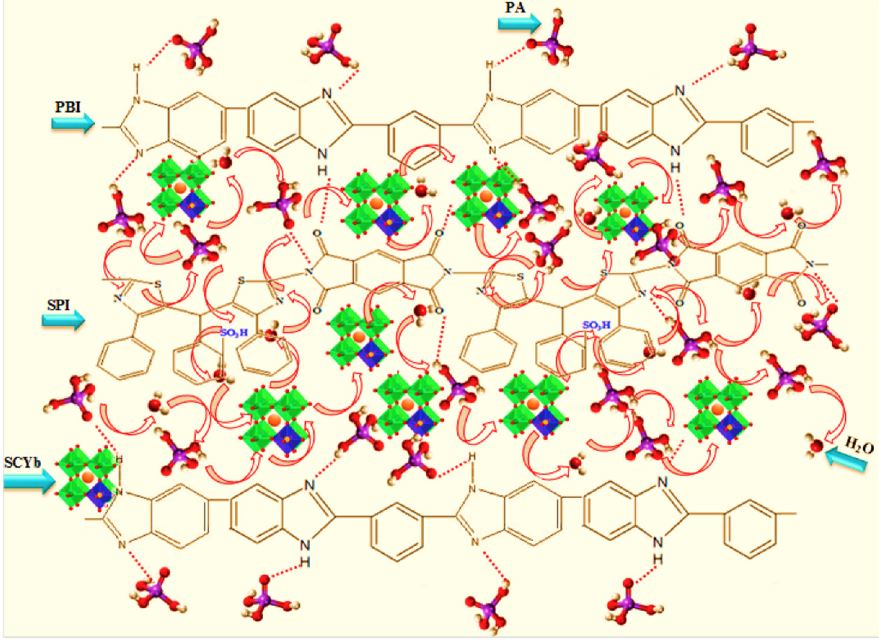
Figure 4. Scheme of the proton transport mechanism for PPBI-SPI 25 -SCYb 7 nanocomposite mem- branes from Ref. [63].